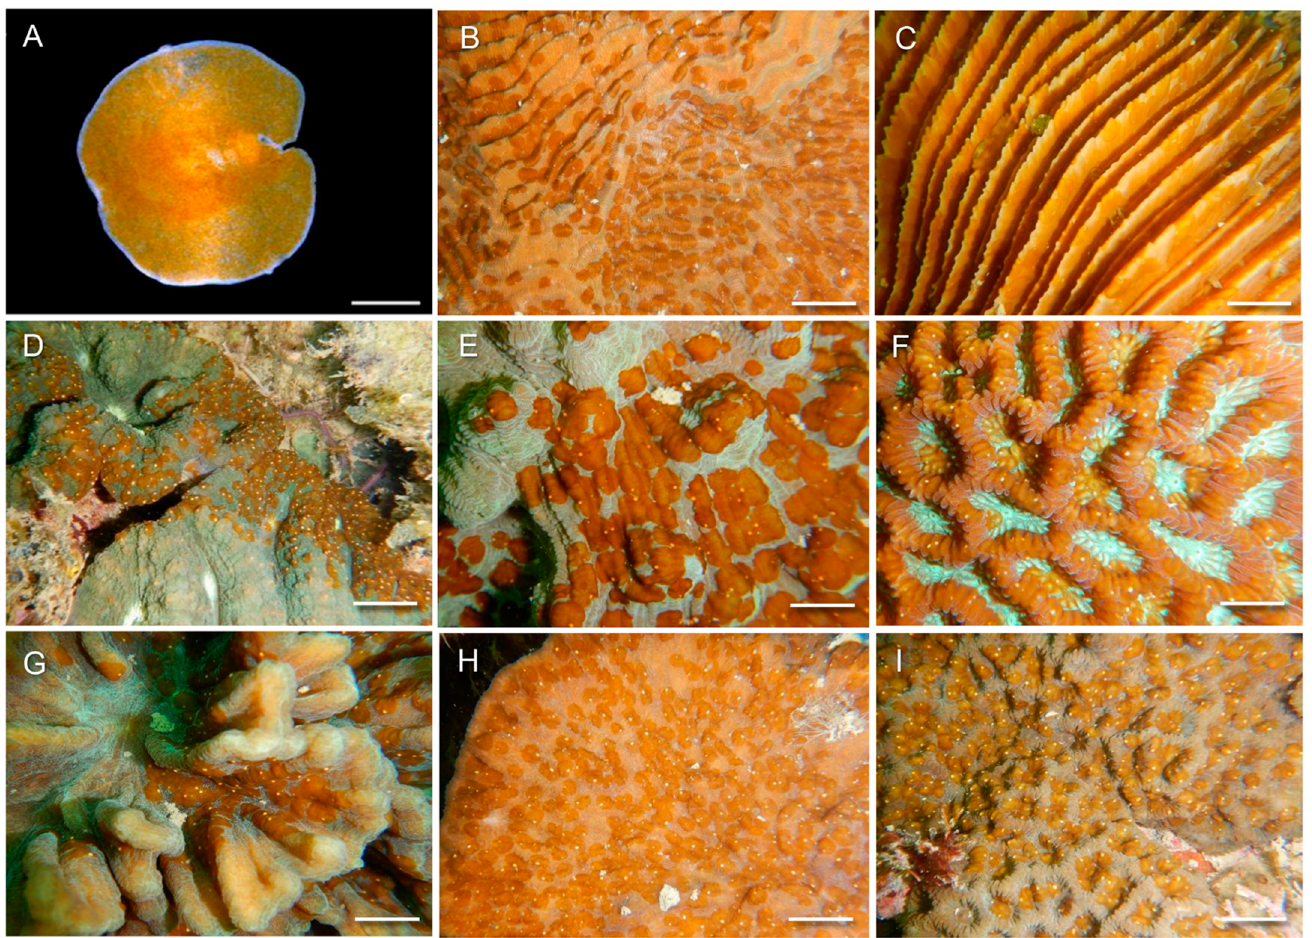
Figure 2. Waminoa sp. individuals in association with different coral genera in Singapore reefs. ( A ) Close up of a single Waminoa sp. individual characterized by an obcordate general shape, body with brown coloration, white peripheral outer edge, white random dots, and white comparatively larger one white internal spot. Flatworms colonizing corals belonging to the genera Pachyseris ( B ), Fungia ( C ), Lobophyllia ( D , E ), Goniastrea ( F ), Pectinia ( G ), Merulina ( H ), and Favites ( I ). Scale bars: 1 mm for ( A ) ~1 cm for ( C , E , F , G ) ~2 cm for ( B , D , H , I ).